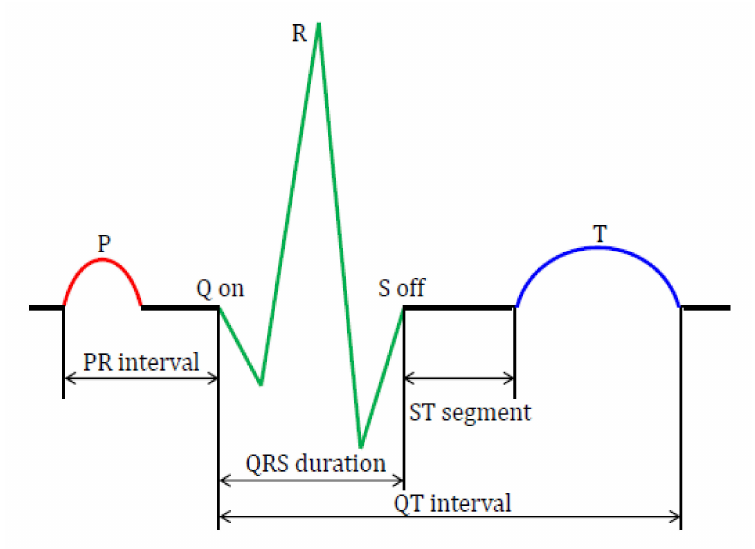
Figure 2. Fiducial points and features of the ECG signal. PR: time interval measured from the beginning of the P wave to the start of the QRS complex, QRS: time interval of the QRS complex, ST: time interval measured after the S wave to the beginning of the T wave and QT: time interval measured from beginning of the Q wave to the end of the T